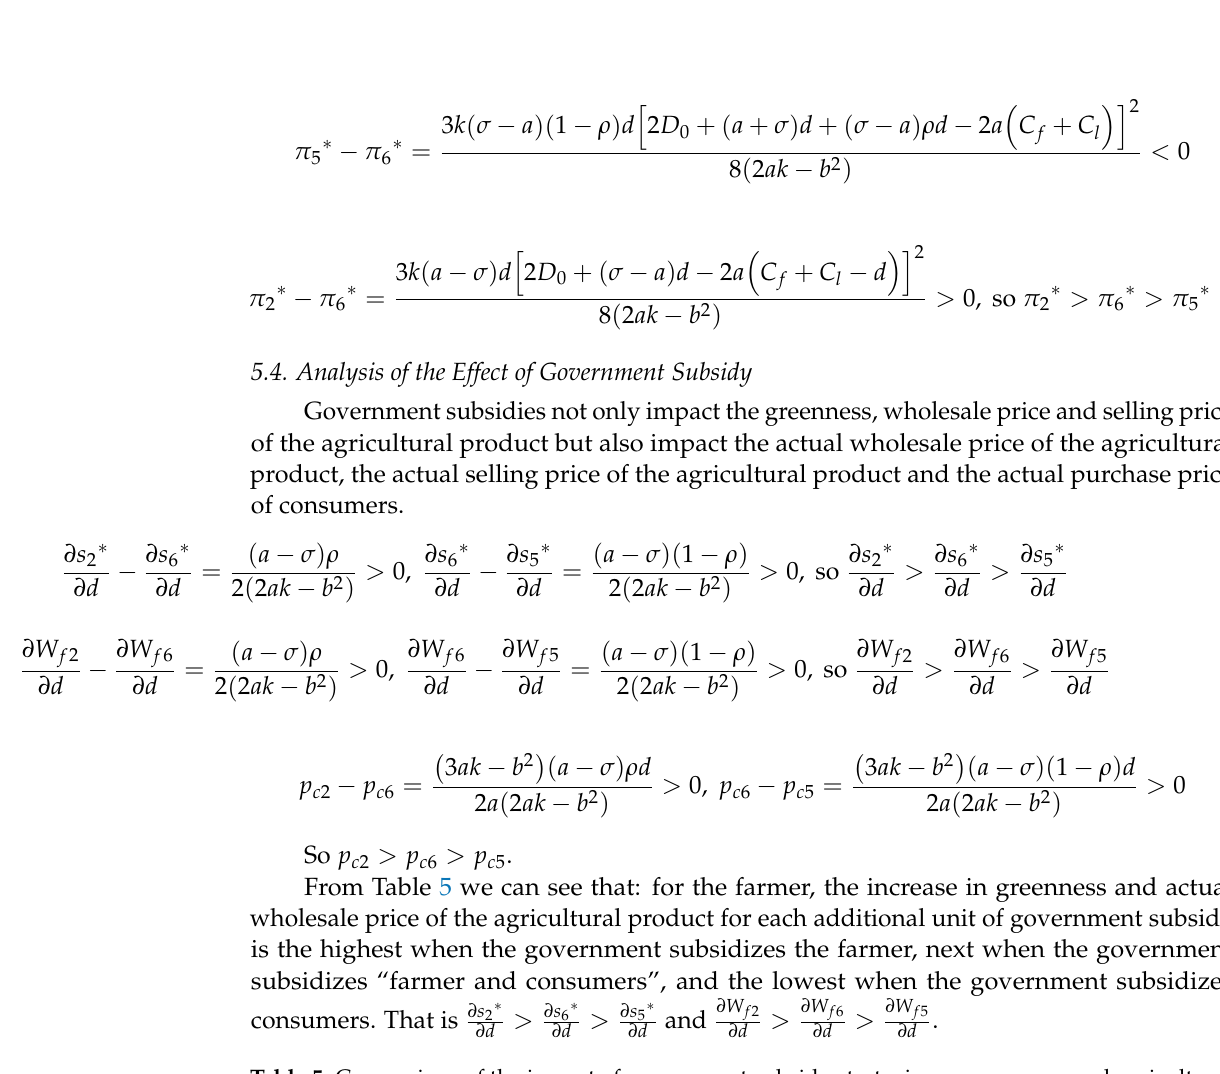
Table 5. Comparison of the impact of government subsidy strategies on greenness and agricultural wholesale prices. Parameter Subsidizing the Farmer Subsidizing Consumers Subsidizing “Farmer +